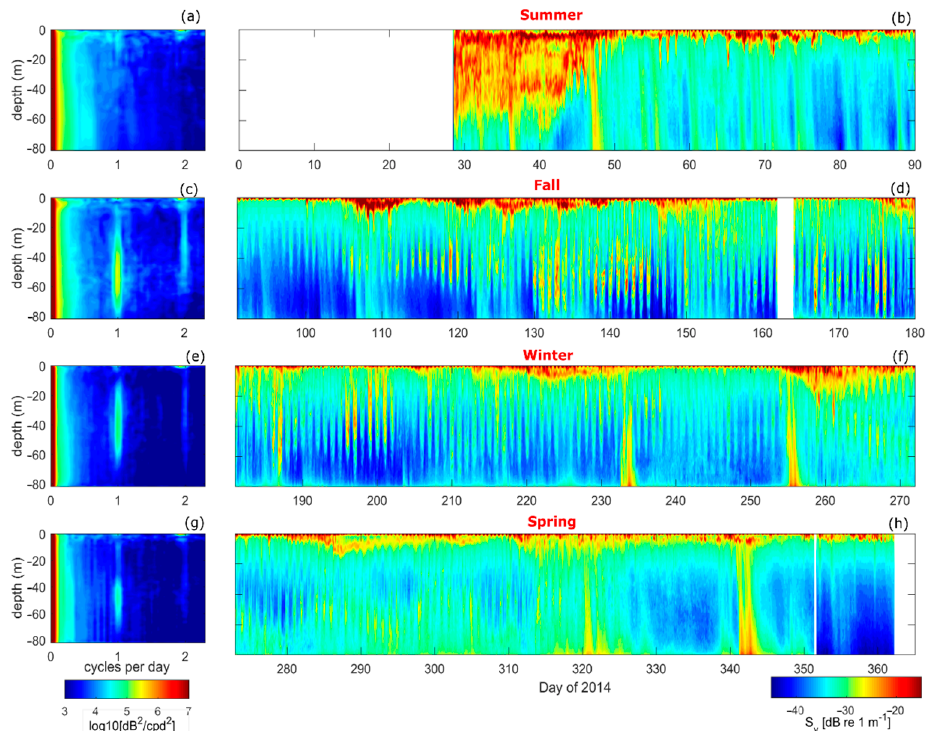
Figure 8. ( a ) Spectra of S v from the austral summer (January–March) at each depth ( y -axis), ( b ) time series of S v from the austral summer. ( c ) and ( d ) are the same as ( a ) and ( b ) but for the austral fall (April–June), ( e ) and ( f ) are the same as ( a ) and ( b ) but for the austral winter (July–September), ( g ) and ( h ) are the same as ( a ) and ( b ) but for austral spring (October–December).